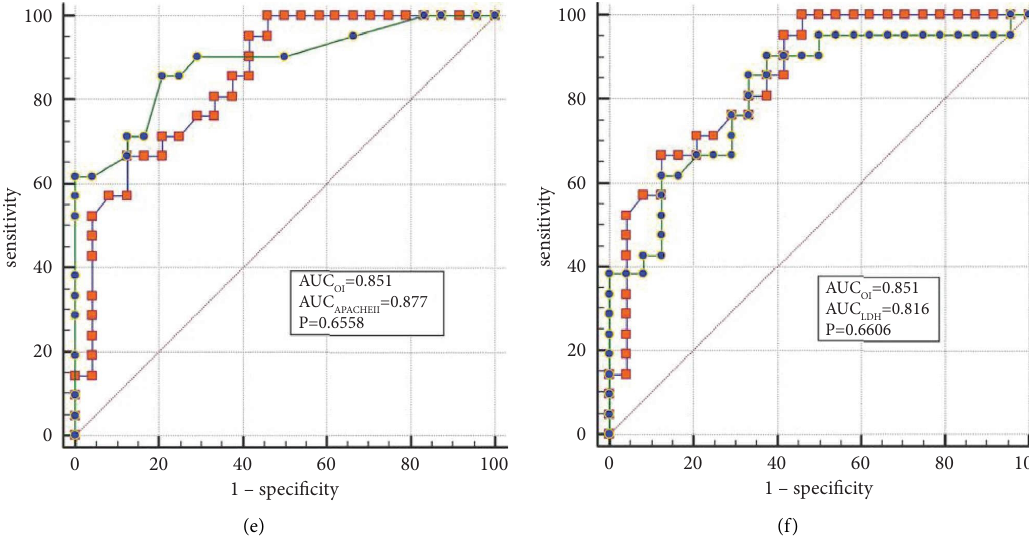
Figure 3: (a) Combining the area under the ROC curve of APACHE II with OLA (AUC � 0.887 vs. AUC � 0.970; P � 0 . 084). (b) Combining the area under the ROC curve of LDH with OLA (AUC � 0.816 vs. AUC � 0.970; P � 0 . 013). (c) Combining the area under the ROC curve of OI with OLA (AUC � 0.851 vs. AUC � 0.970; P � 0 . 024). (d) Combining the area under the ROC curve of OL with OLA (AUC � 0.885 vs. AUC � 0.970; P � 0 . 042). (e) Combining the area under the ROC curve of OA with OLA (AUC � 0.950 vs. AUC � 0.970; P � 0 . 310) (f) Combining the area under the ROC curve of LA with OLA (AUC � 0.964 vs. AUC � 0.970; P � 0 .